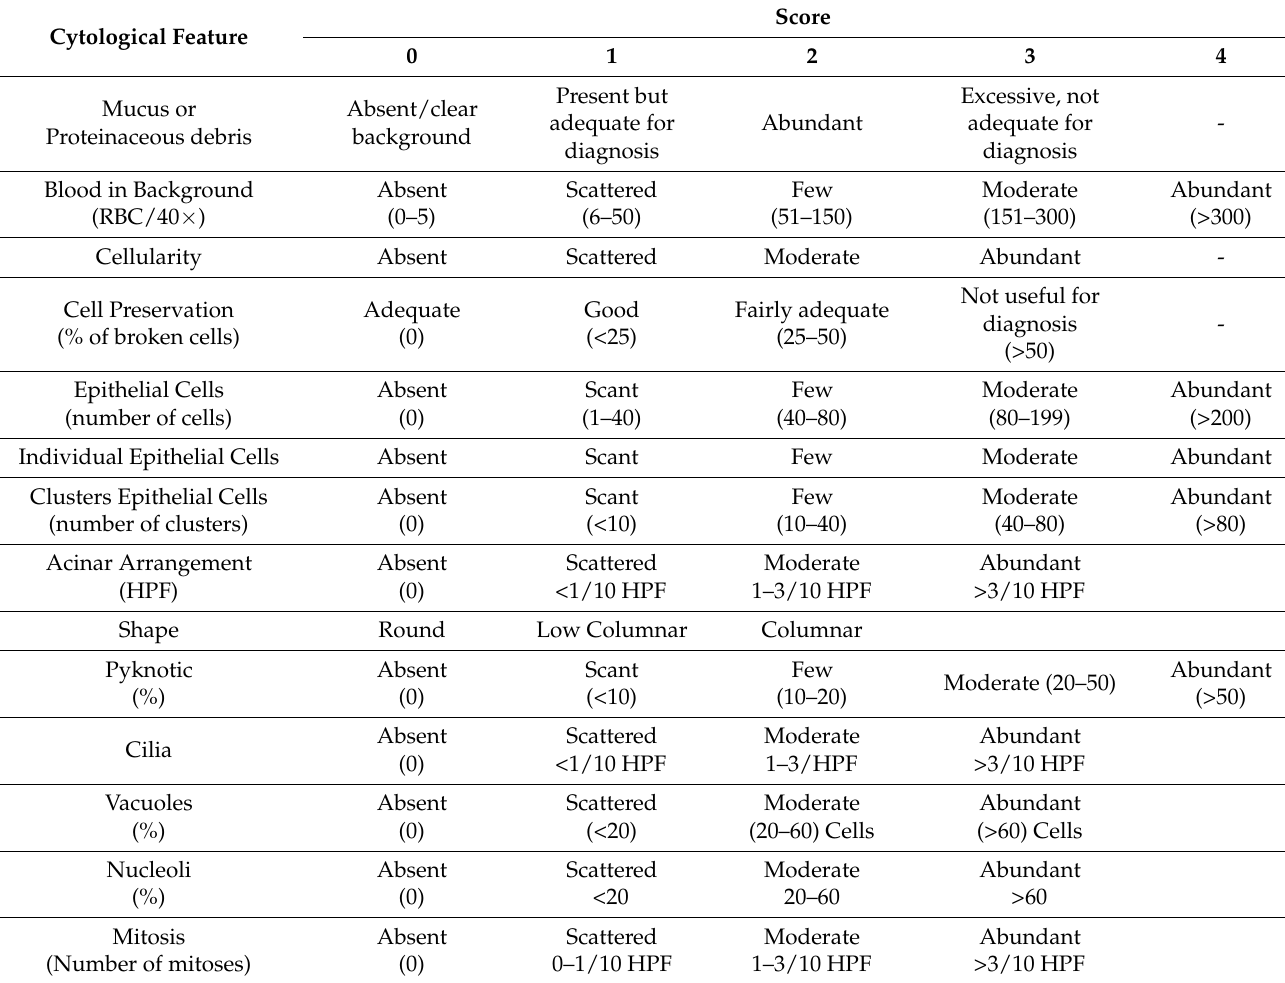
Table 2. Cytologic features evaluated in the smears obtained with the uterine lavage and the uterine swabbing sampling methods. Cytological